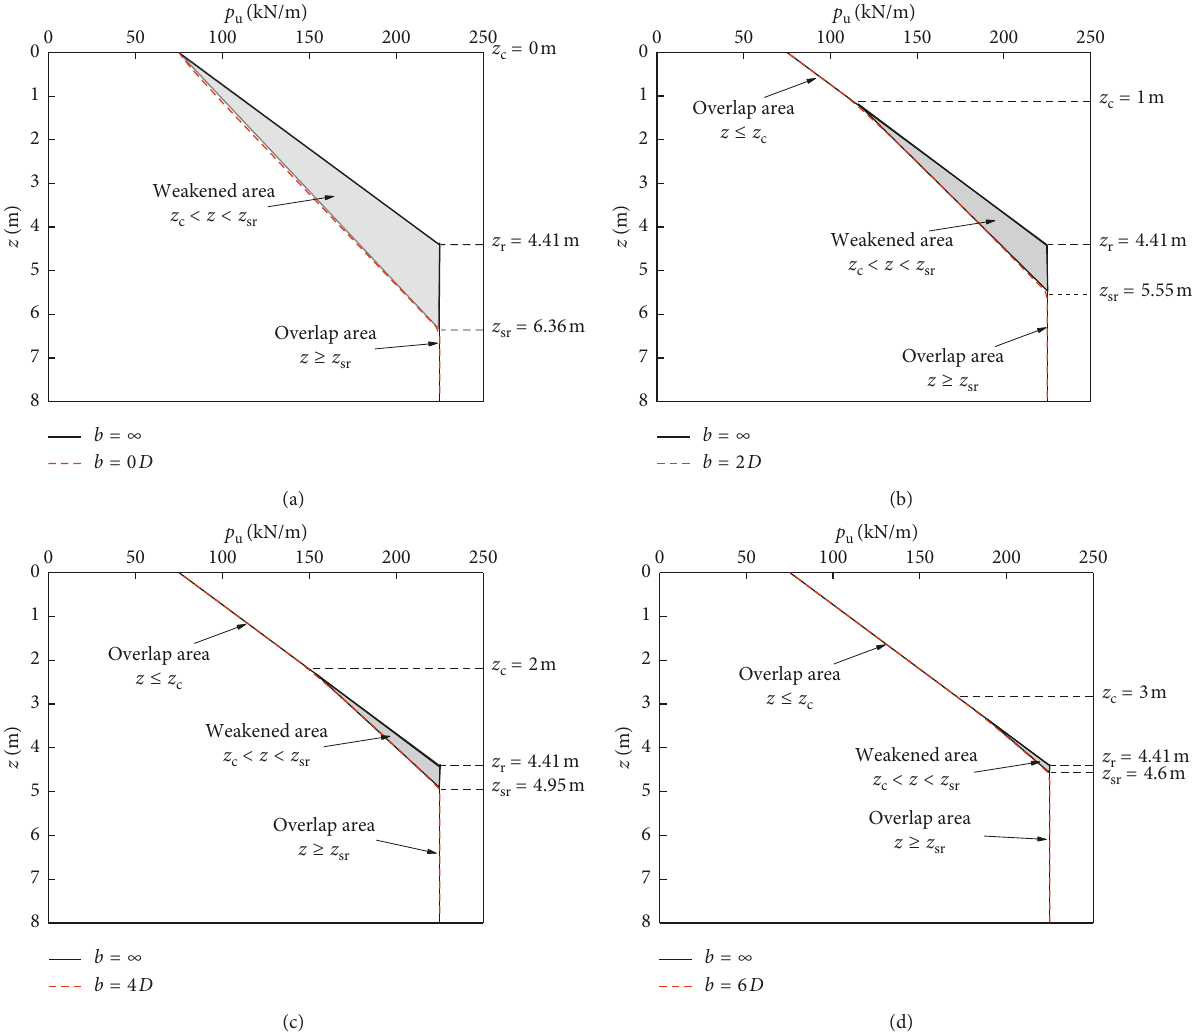
Figure 8: Comparison of limited resistance of soil with different depth along the pile: (a) b � 0 D ; (b) b � 2 D ; (c) b � 4 D ; (d) b � 6 D .